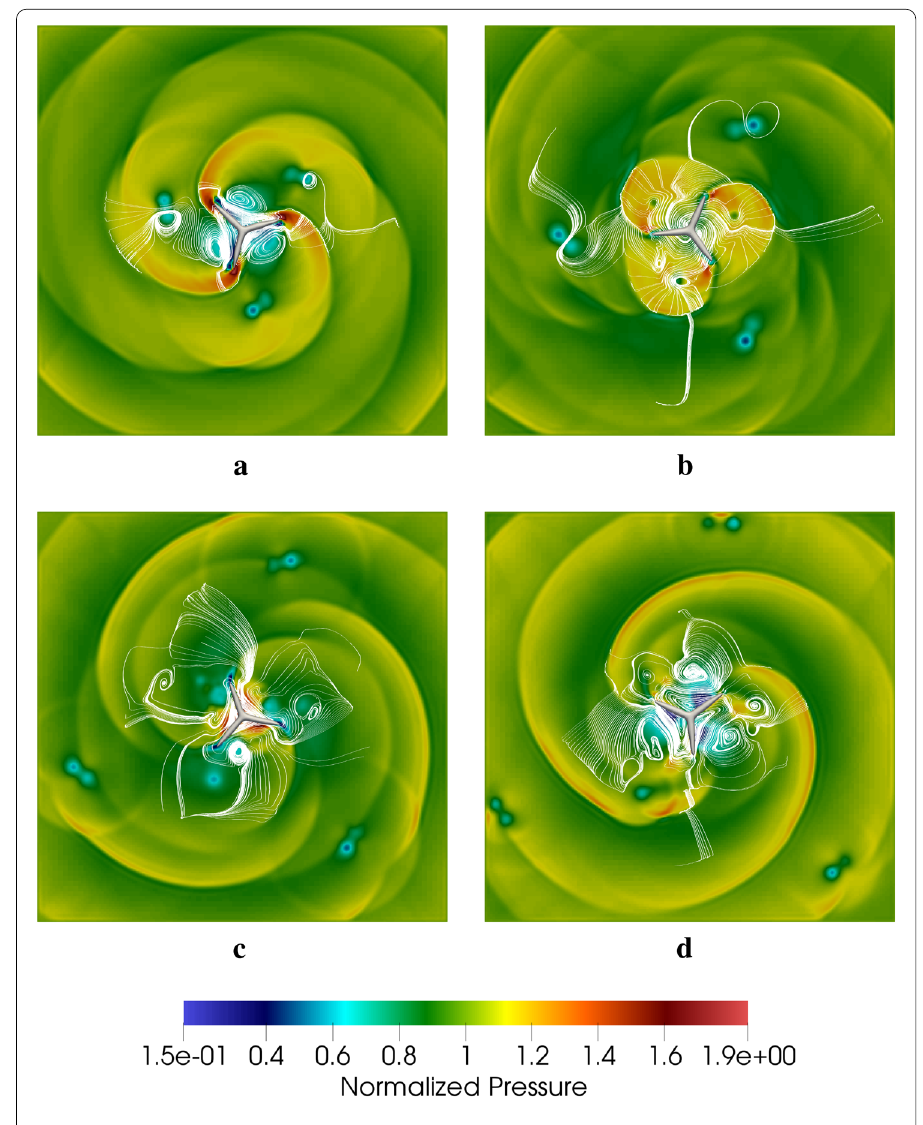
Fig. 15 Rotation of a fan composed by three NACA0012 airfoil profiles. The depicted pressure is normalized by the background pressure. The rotational movement is captured after: a 5 s , b 10 s , c 15 s and d 20 s . The normalized pressure is shown in the background. The streamlines (white) illustrate the velocity flow